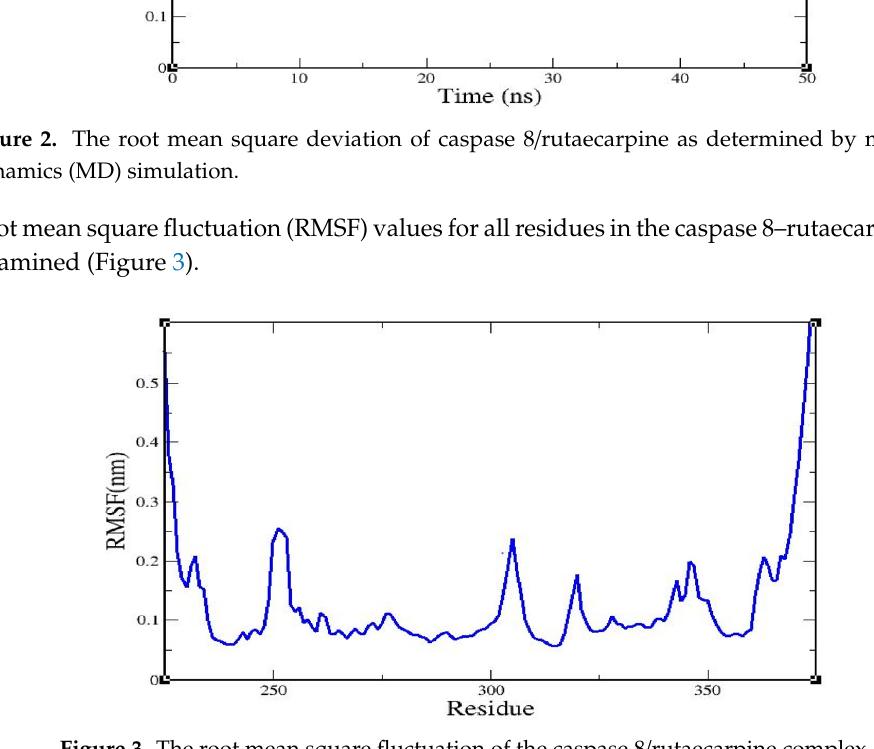
Figure 3. The root mean square fluctuation of the caspase 8/rutaecarpine complex.